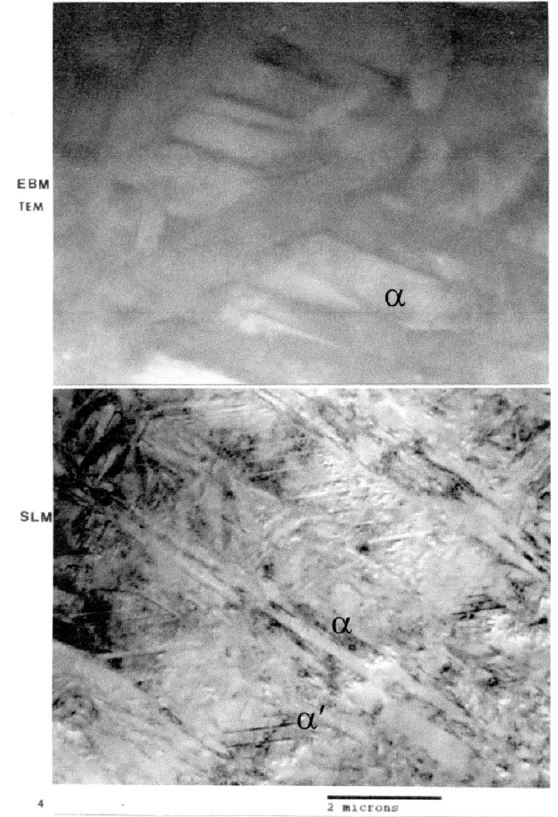
Figure 9. TEM views of EBM- α - phase and SLM mixed α - α ′ (with some twinning in